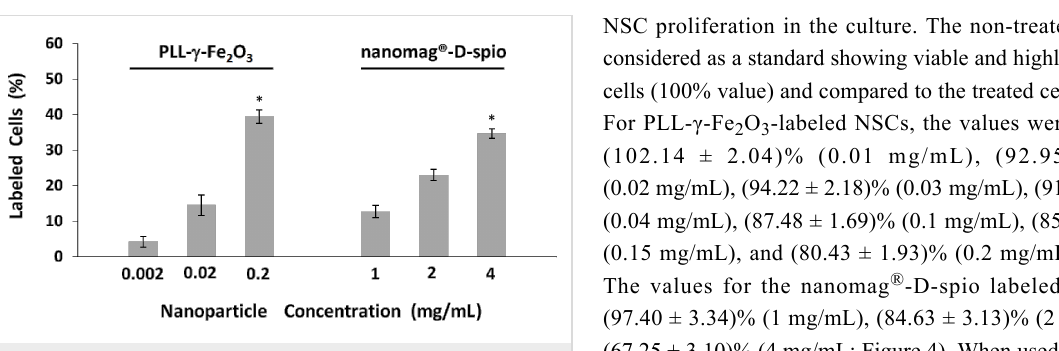
Figure 3: Quantitative analysis of NSC labeling of PLL- γ -Fe 2 O 3 and nanomag ® -D-spio nanoparticles. Overtone cumulative histogram subtraction of flow cytometry histograms of NSCs labeled with differ- ent concentrations of PLL- γ -Fe 2 O 3 (A) and nanomag ® -D-spio (B) nanoparticles ( N = 5). The asterisk indicates a statistically significant difference ( P < 0.05) versus other concentrations of the same nanopar- ticle.